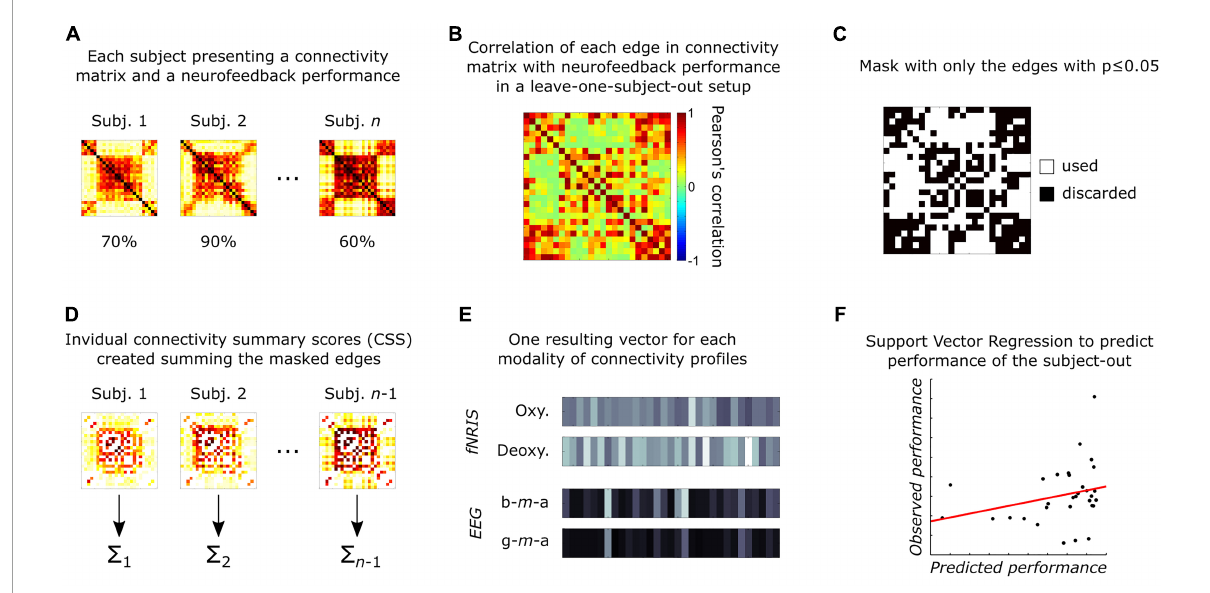
FIGURE2 Schematic representation of the connectivity-based predictive modeling (adapted from Shen et al., 2017), summarized as: (A) Each participant has one connectivity matrix per neuroimaging feature and one performance measurement related to the affective neurofeedback task; (B) each edge in connectivity matrices is related to the subject’s performance using Pearson’s correlation in a leave-one-subject-out (LOSO) setup; (C) next, significant edges ( p ≤ 0.05) are selected to create a mask; (D) then, for each subject in the training group, the mask is applied to select most important edges, which are then summarized (summed) into a single CSS value per subject; (E) next, an inter-subject vector is created for each neuroimaging modality, containing the respective summary values; (F) finally, these four vectors are used to train a support vector regressor (SVR) and test it in the